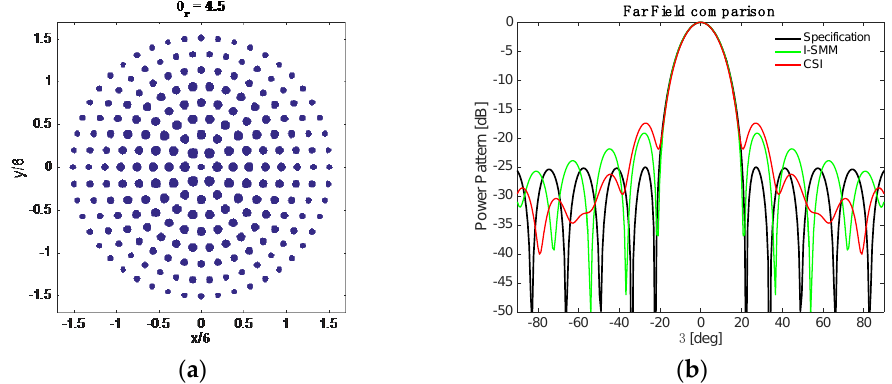
Figure 3. Synthesis of radius values for a GAM F -based lens with fixed permittivity [ 𝜏 = −1.1991 − j0.4658]. ( a ) Real part of the permittivity function; ( b ) comparison on radiated far field.